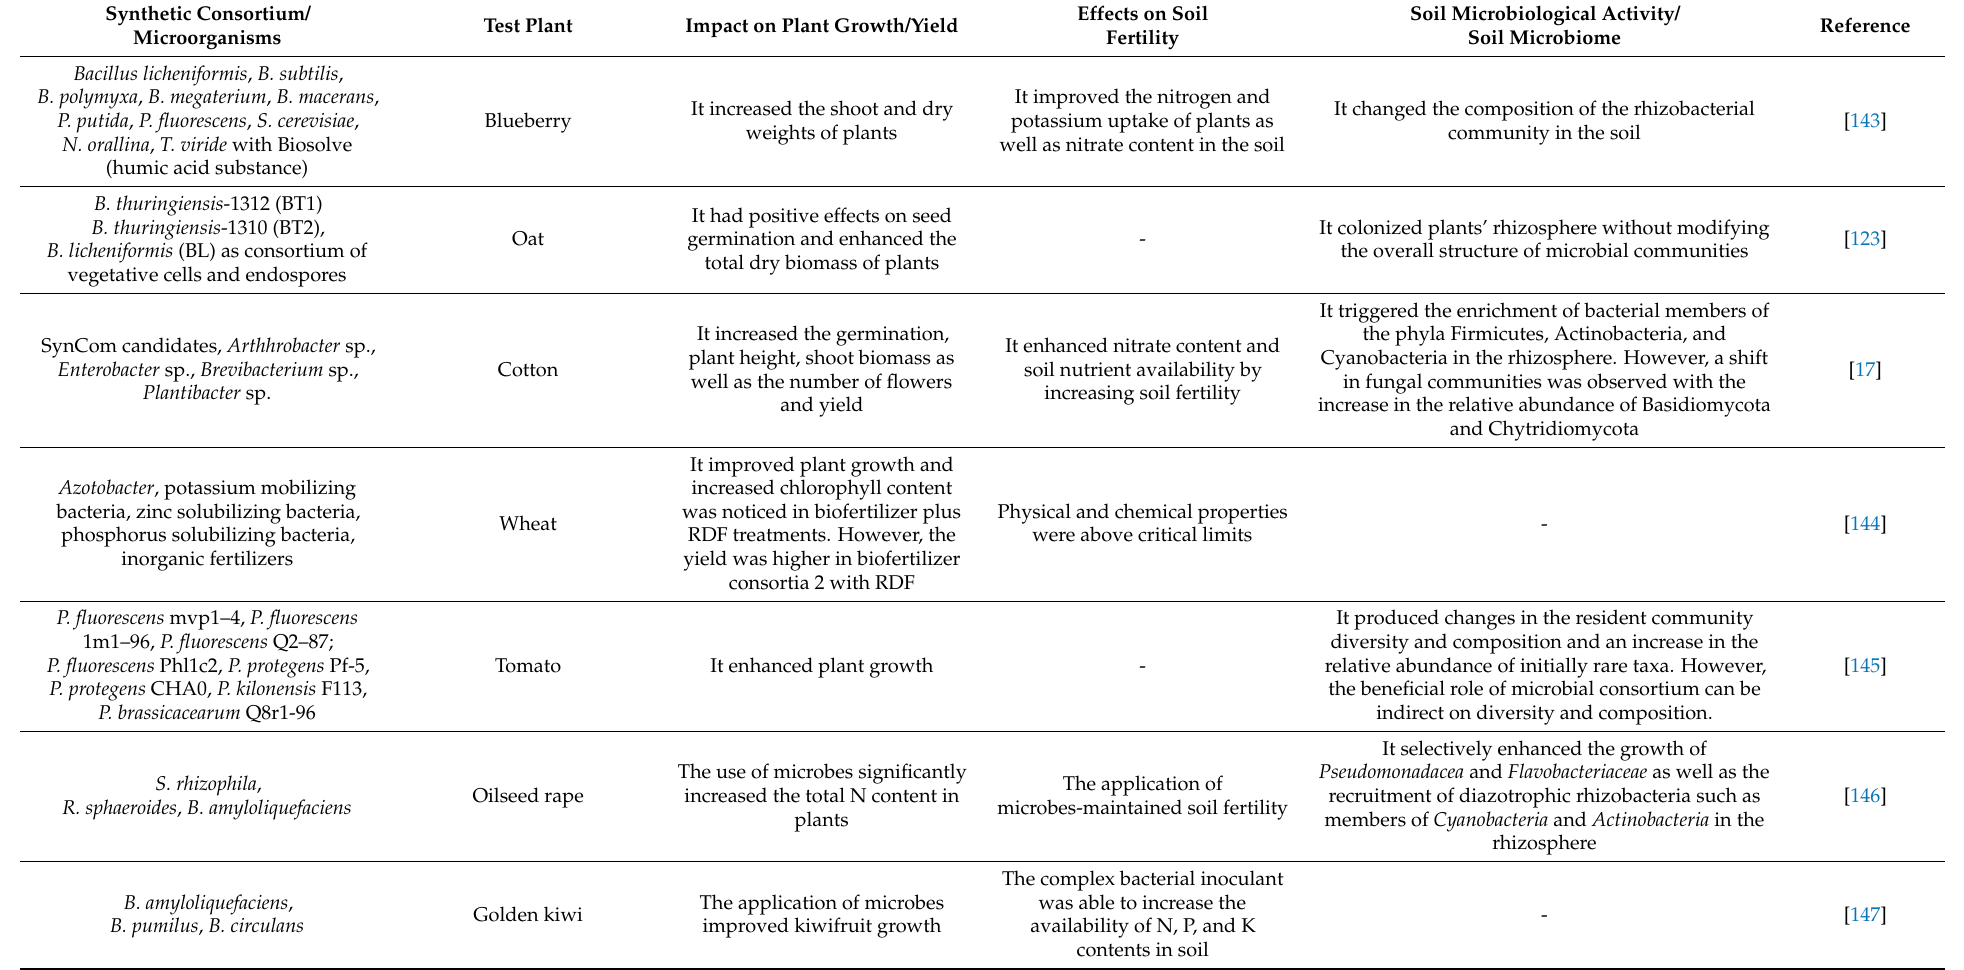
Table 1. Influence of synthetic consortium on crop yield improvement, soil fertility, and soil